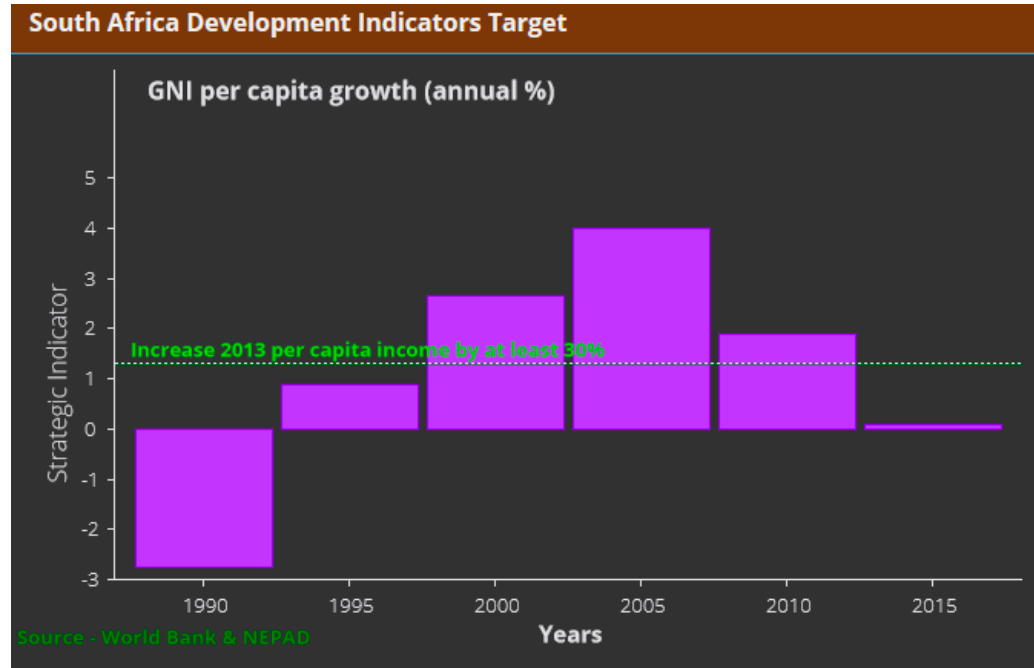
Figure 14. Gross national income (GNI) per capita growth information displayed by the front end.